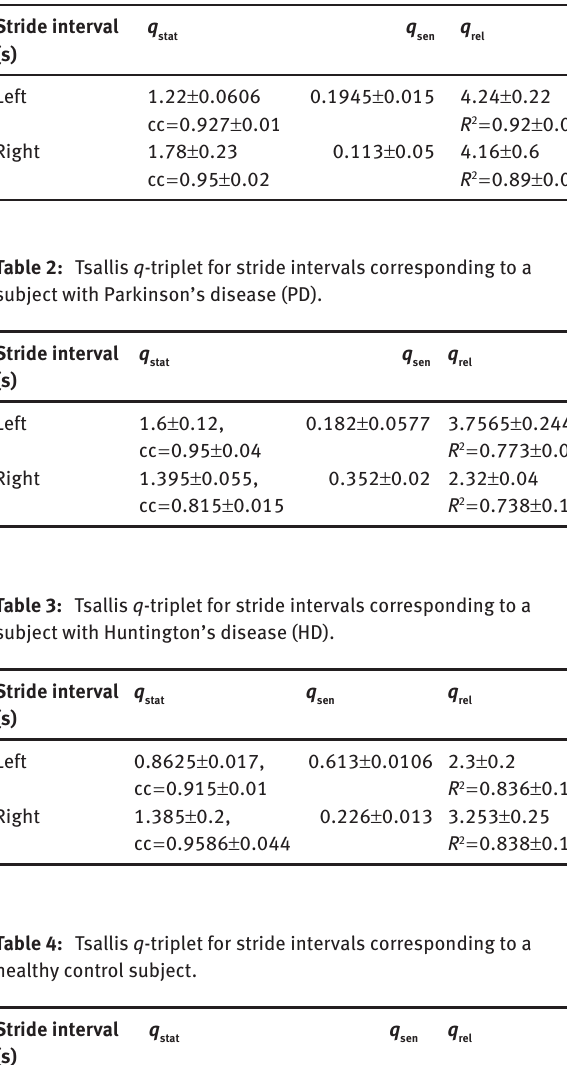
Table 1: Tsallis q -triplet for stride intervals corresponding to a female subject with amyotrophic lateral sclerosis (ALS).